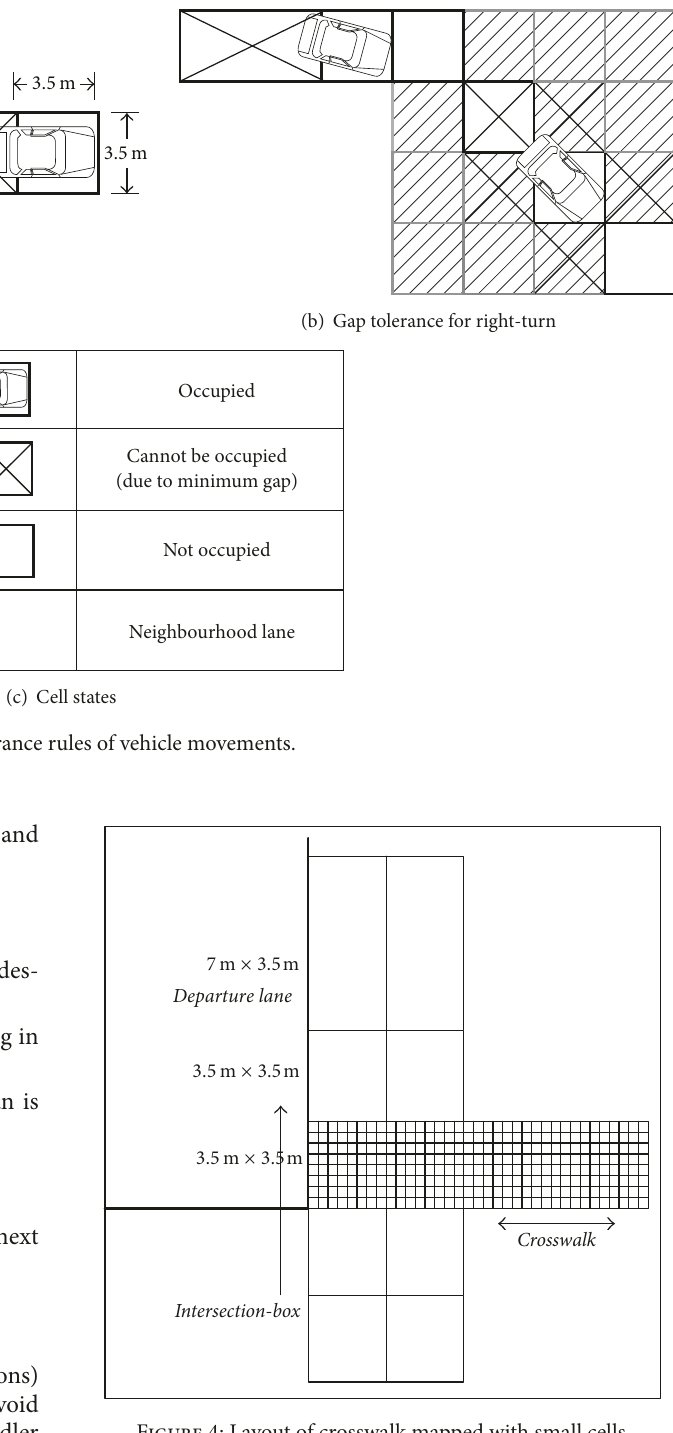
Figure 4: Layout of crosswalk mapped with small